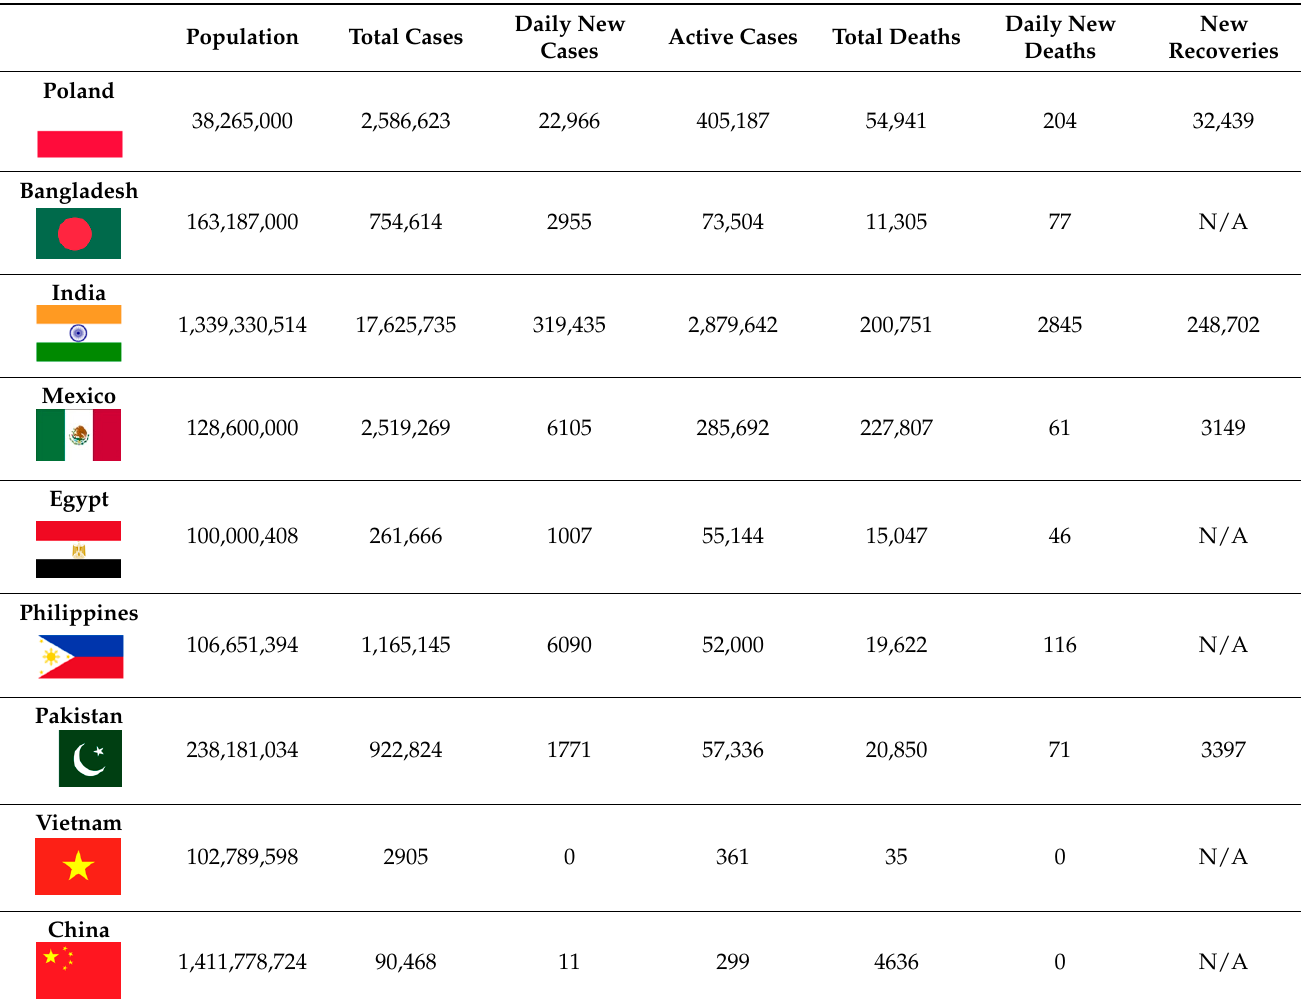
Table 1. The epidemic situation in all countries participating in the study on the first day of survey distribution.